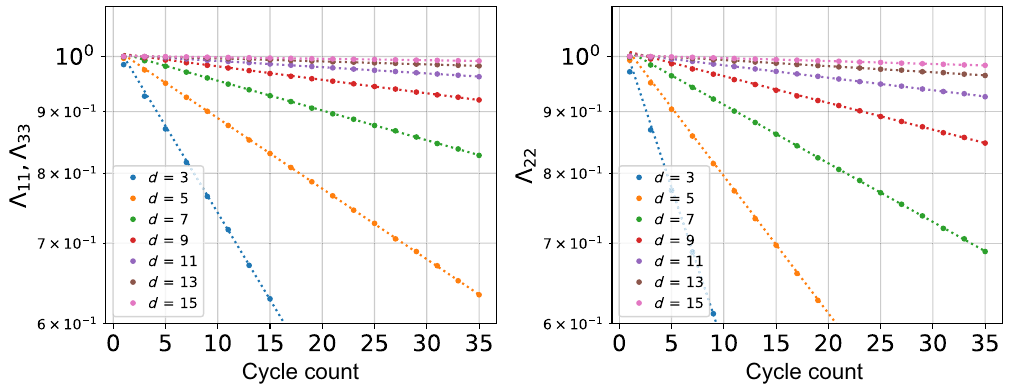
FIG. 12. Diagonal elements of Pauli transfer matrix for a noise map of a single logical qubit during c syndrome-measurement cycles plotted versus the number of code cycles. Each color corresponds to the code distance of a logical qubit. The circles are numerical results, and the dashed lines are fitting results with an exponentially decaying